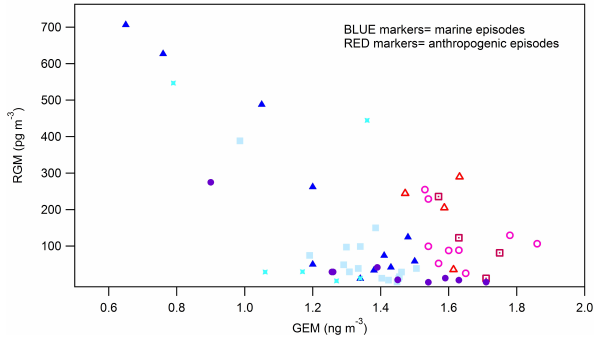
Fig. 6. Ten-day HYSPLIT airmass back trajectories for the marine boundary layer (MBL) high-RGM events. Trajectories were initial- ized at times during each event when the highest RGM/GEM-ratios were